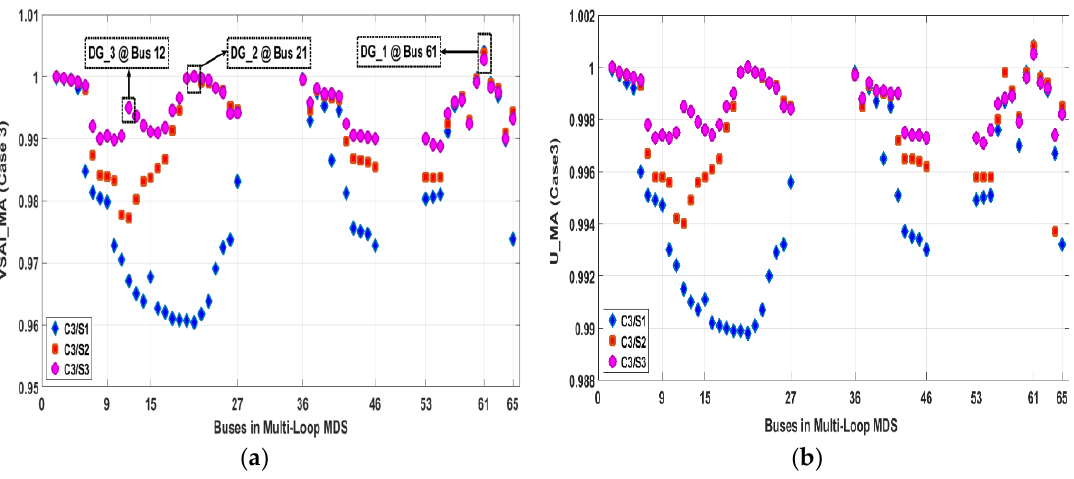
Figure 15. Case 3 for 69-bus MDS(U_Max) ( a ) VSAI trend (based on actual MDS) for VSAI_MA-LMC; ( b ) U-profile trend for VSAI_MA-LMC, based planning approach (DG operating @ pf = 0.9 ± 2.5%).